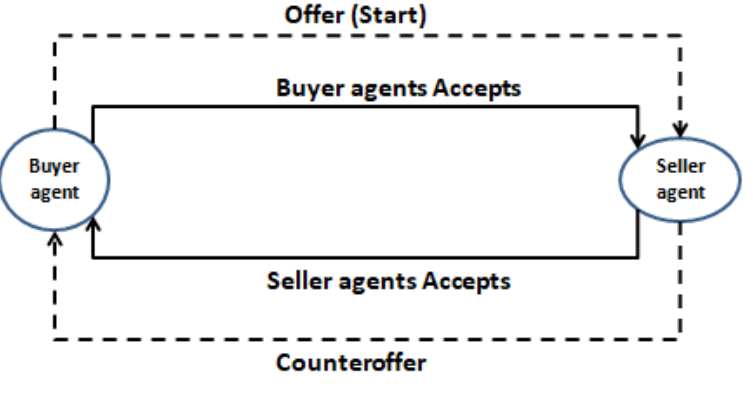
Figure 3. Negotiation Process.